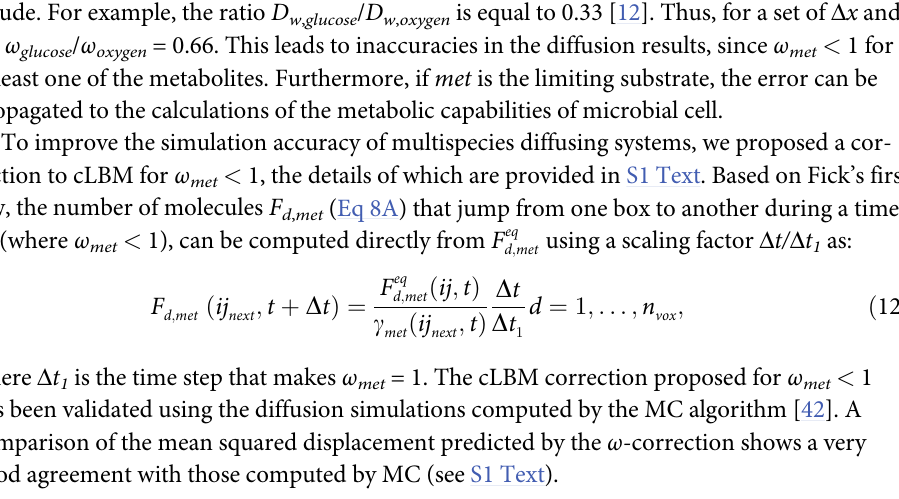
S1 Fig. Spatial distribution of the metabolites and phenotypes predicted for the E . coli bio- film with a glucose supply of 2.25 mM at different times. Crowding assumption C1 was used for the simulations. S2 Fig. Volume fraction occupied by cells in the E . coli biofilm at different times under crowding assumption C1 and 2. The glucose supply was set to 2.25 mM. S3 Fig. Dynamics of the E . coli biofilm with a glucose supply of 2.25 mM under different crowding assumptions. 2D microbial system was discretized using a square lattice. (A) Bio- mass. (B) Acetate produced. (C) Active layer depth H normalized by Δ x . (D) Number cells identified with phenotype respiration: glucose + O ➔ (acetate) + biomass, fermentation: glu- 2 cose ➔ acetate + biomass, and inactive cells. S4 Fig. Parity and residual plots of the metabolic fluxes predicted by the allocation version of thermodynamics flux analysis (aTFA) and the neural network (NN) created for E . coli . The NN with 2 hidden layers of 15 neurons each was trained using 100 K random samples. The normalized mean square error between the fluxes predicted by aTFA and NN was esti- mated to be 8.5 x 10 − 5 , while the Pearson correlation r is 1. Fluxes v are given in mmol g DW-1 f h -1 , while the growth rate v is in h -1 bio